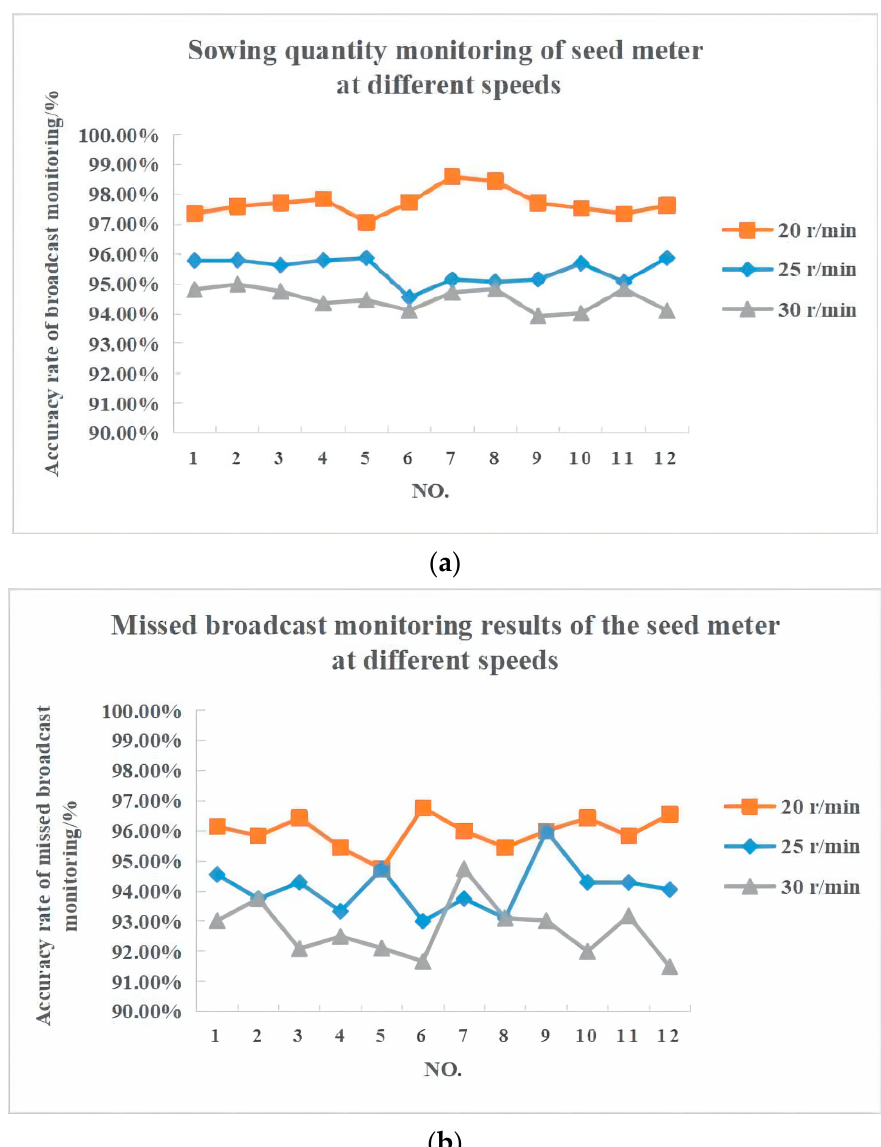
Figure 10. The field sowing monitoring curve of the seed meter at different speeds: ( a ) sowing rate monitoring and ( b ) missed broadcast monitoring.